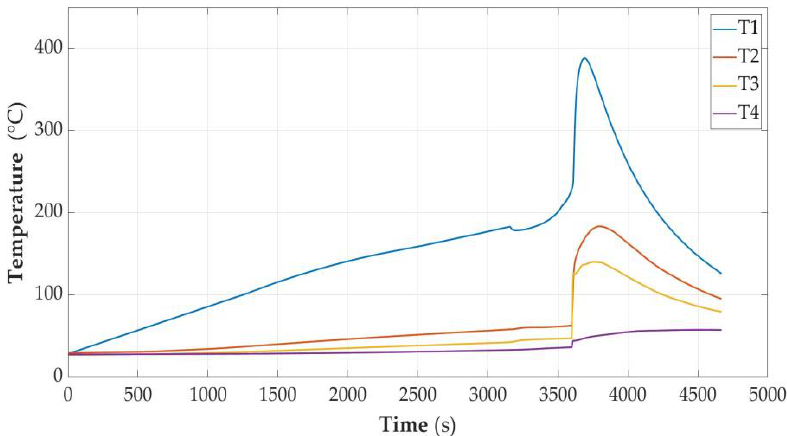
Figure 6. Graphs of temperature changes during heating and energy supplied to the cell module in the SOC = 30% state.